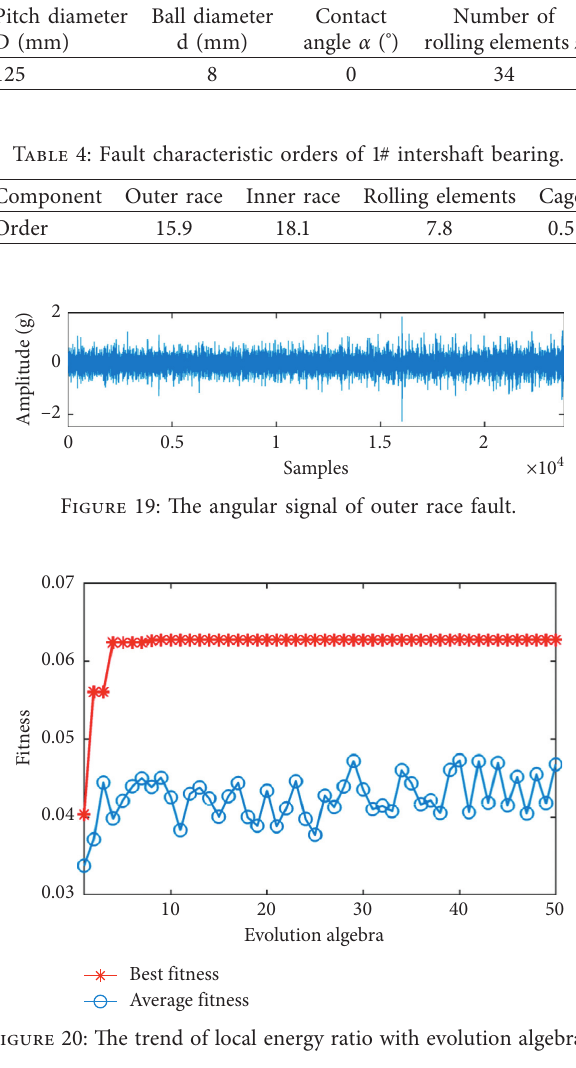
Table 3: Geometrical parameters of 1# intershaft bearing. Pitch diameter